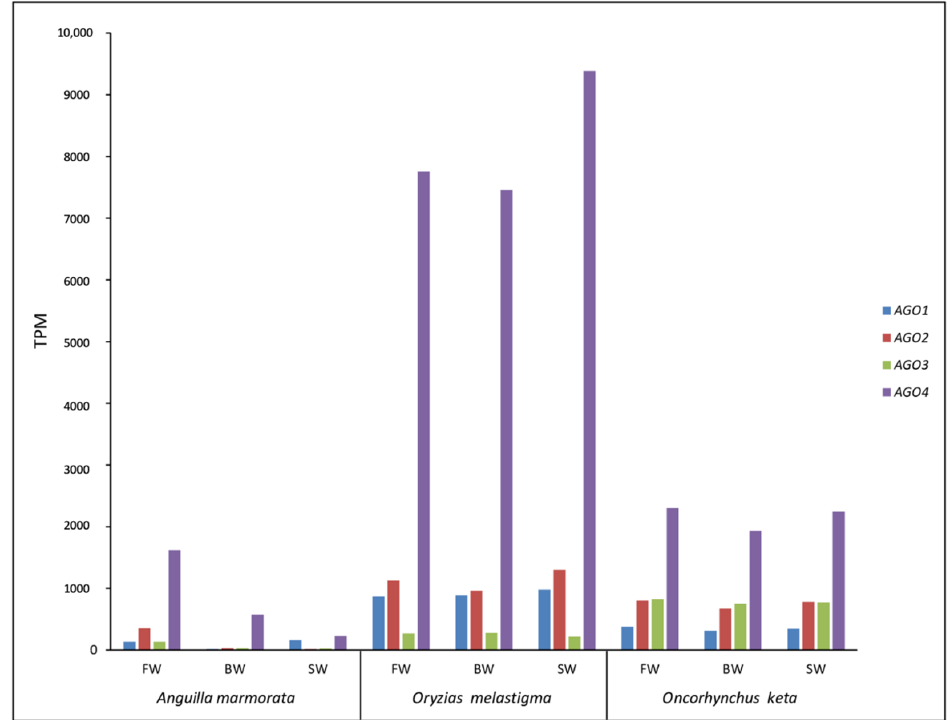
Figure 2. Transcriptional activity of Argonaute genes in Anguilla marmorata, Oryzias melastigma, and Oncorhynchus keta gill transcriptomes. FW: freshwater; BW: brackish water; SW: salt water. Concerning genes related to heterochromatin formation, HP1 α transcript was identified in O. keta and O. melastigma with a complete CDS; for HP1 β , two transcripts corresponding to HP1 β a and HP1 β b were retrieved in A. marmorata and O. melastigma, and one transcript corresponding to HP1 β b was identified in O. keta . All HP1 β sequences presented a complete CDS. For HP1 γ , a transcript was retrieved in all species (Table S2). This gene was the most expressed in A. marmorata and O. keta . In the case of O. melastigma, HP1 β a showed the highest transcriptional levels. The HP1 α was the second gene having a remarkable transcriptional activity in O. melastigma and in O. keta (Figure 3). A sequence homologous to DNMT1 was retrieved in all considered species while DNMT3Aa was identified in chum salmon and marine medaka transcriptomes. The expression of DNMT1 was appreciable in all analyzed RNA-Seq data. Moreover, in O. melastigma , among the DNA methyltransferases, the DNMT3Aa showed higher transcriptional levels than DNMT1 (Figure 3).